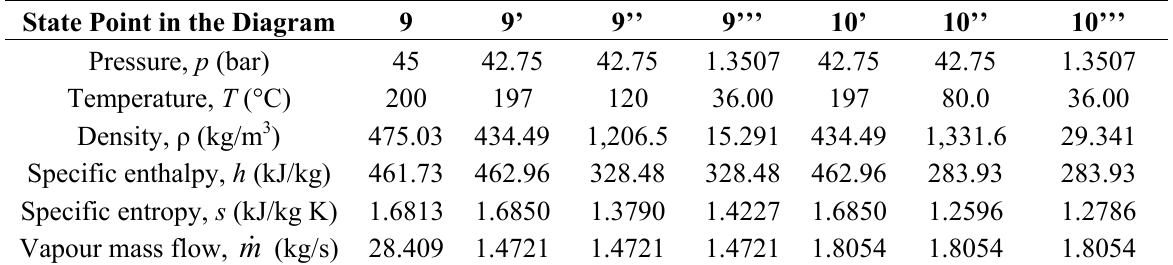
Table 5. State points of working fluid R123; HFO feeder/booster heating and other heating. State Point in the